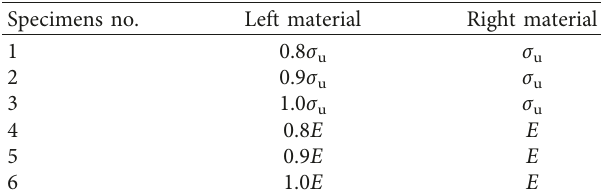
Table 2: The material properties used to model the material mismatch (right metal is A508).